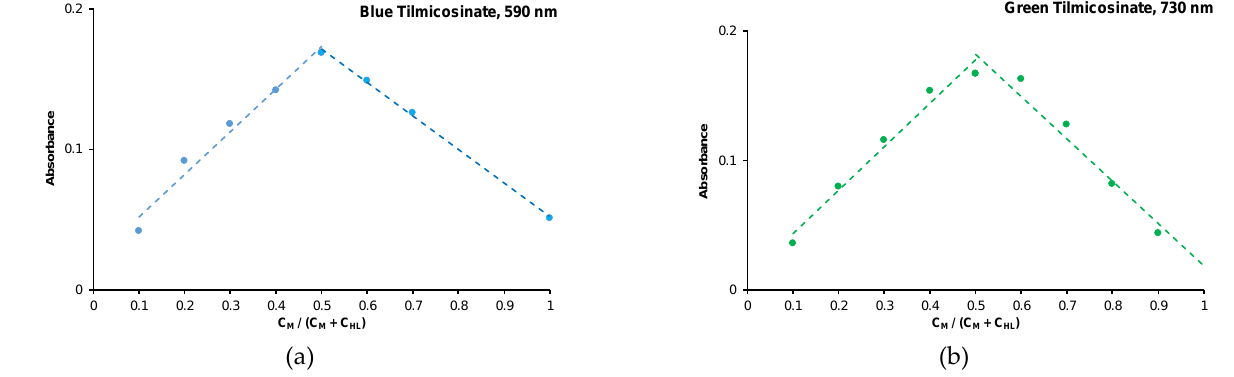
Figure 2. Job’s plots of the ( a ) blue and ( b ) green tilmicosinates derived from the absorption spectra of acetone mixtures containing copper(II) nitrate or copper(II) chloride and tilmicosin at metal-to-ligand molar ratio varying from 1:9 to 10:0. The sum of the metal(II) ion (C M ) and ligand (C HL ) molar concentrations was kept constant at a persistent total volume of the corresponding reaction mixtures. Table 2. Elemental analysis data for the blue and green macrolidates (the composition and MW of both the mono- and dinuclear species are presented).